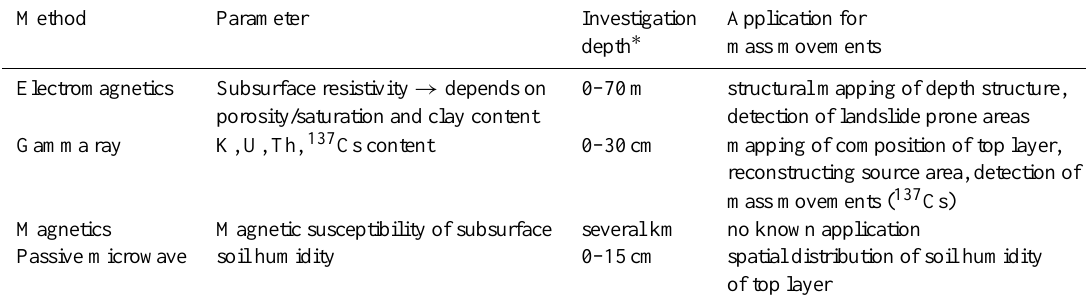
Table 1. Comparison of the different components of the airborne system.